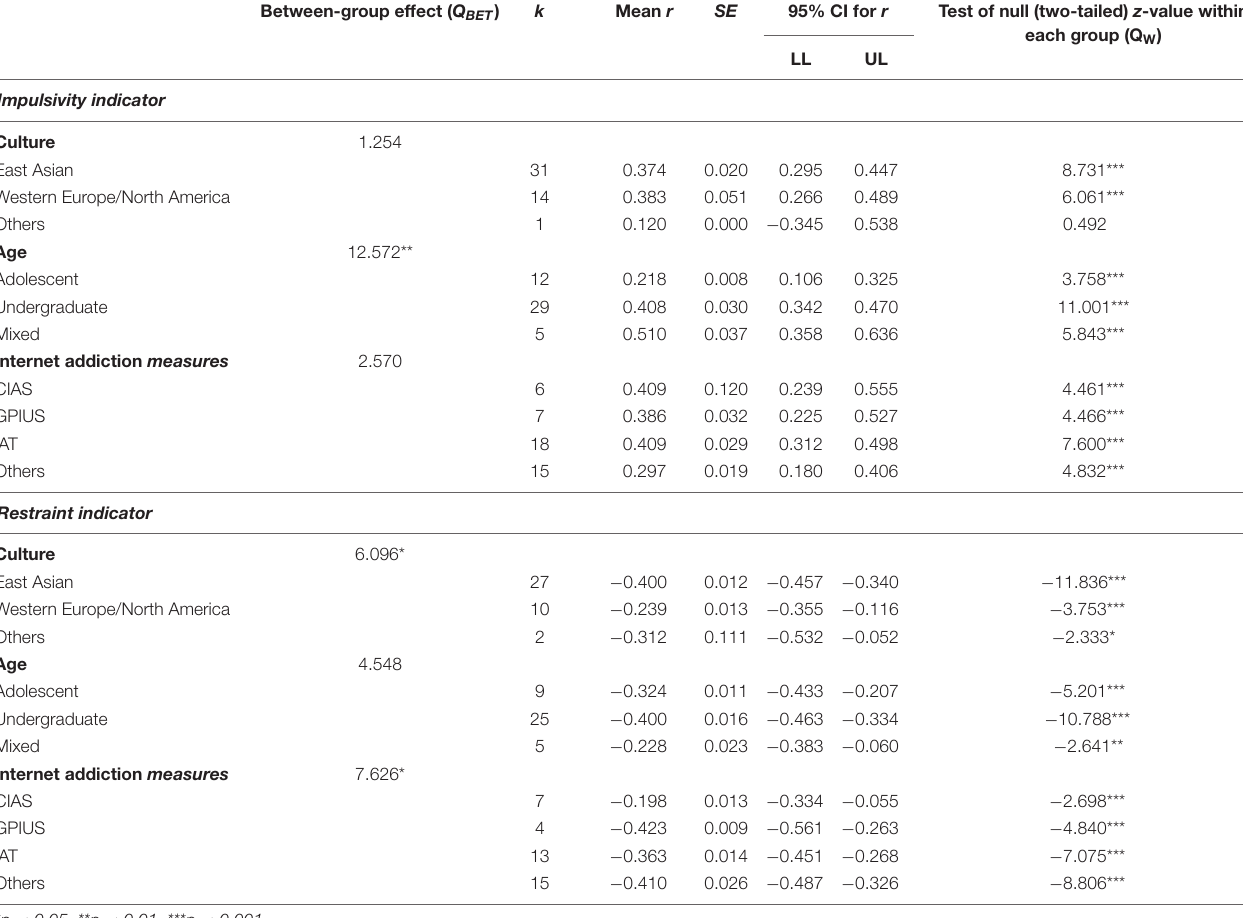
TABLE 3 | Culture and age moderated links between self-control and Internet addiction.